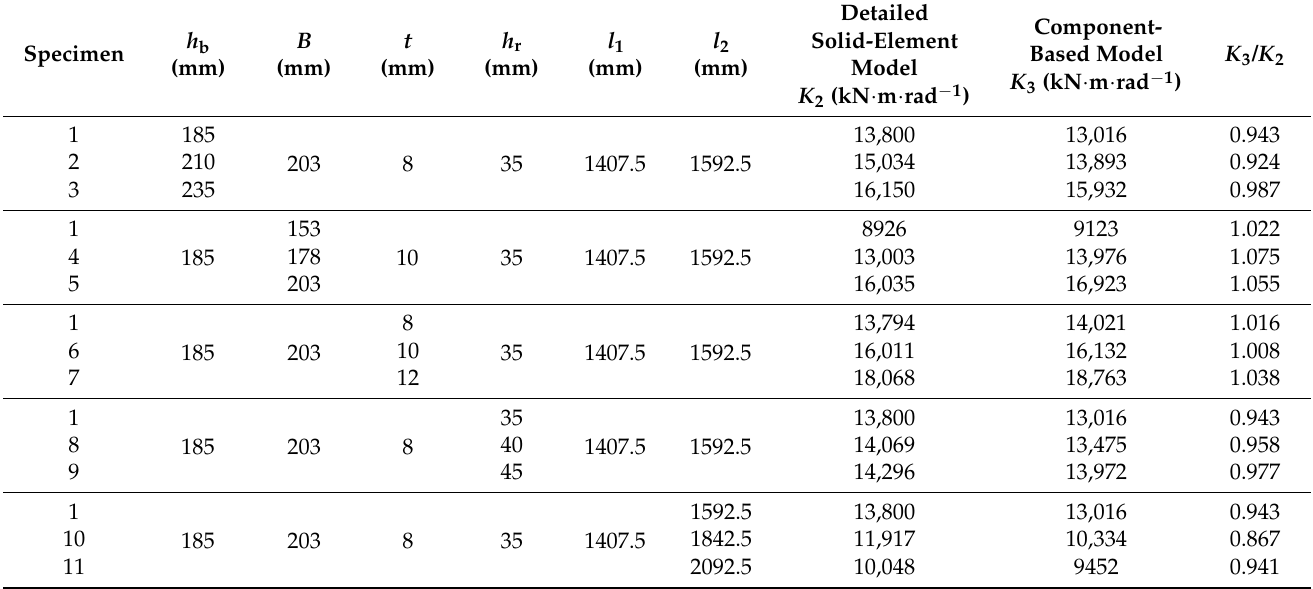
Figure 18. Different models of the CSS joint with circular tube columns to simulate the test specimen in reference [38]: ( a ) Detailed solid-element model; ( b ) Component-based model. In Table 4, the initial rotational stiffness results of the test specimens, detailed solid- element models, and the component-based models are consistent with each other, which proves the applicability of the joint springs in the component-based model to simulate the H-shaped beam to circular-tube-column joints with CSS. Based on the validation above, parameterized analysis of the initial rotational stiffness obtained from the component-based model was further conducted by varying the parame- ters in Equations (1)–(7). Compared with the numerical simulation results of the detailed solid-element models, the parameterized results are listed in Table 5. The results indicate that the initial rotational stiffness results of detailed solid-element models are consistent with those of the component-based models, which further verifies the applicability of the component-based model for the H-shaped beam to circular-tube-column joint with CSS. Table 5. Parameterized analysis results of the initial rotational